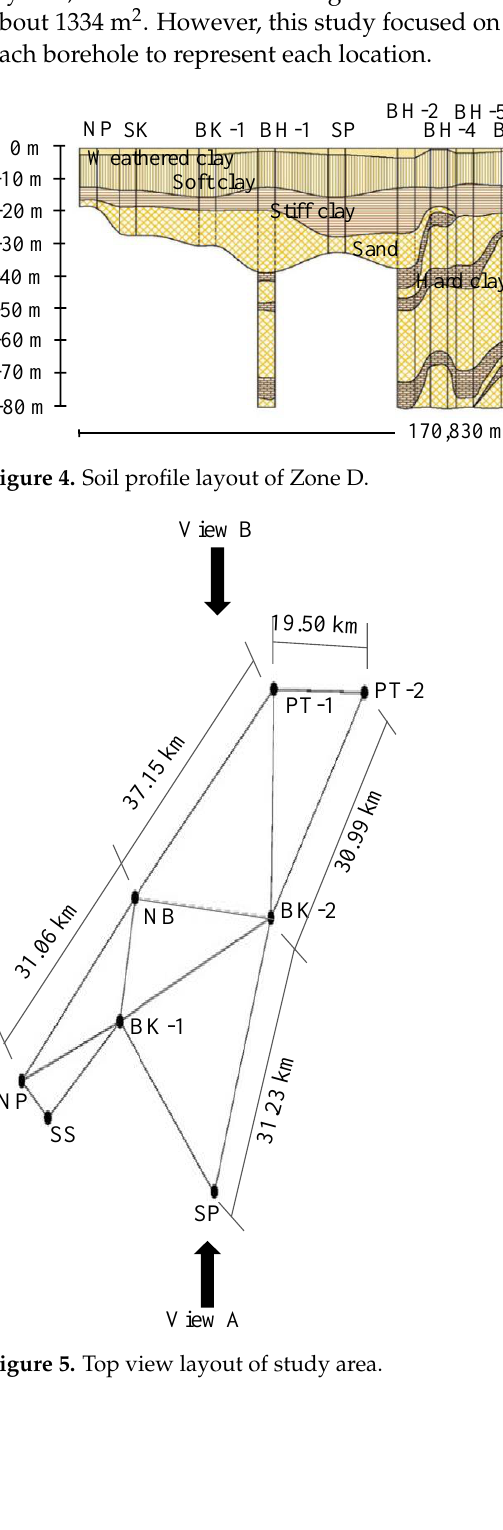
Figure 6. A 3D schematic of View A.